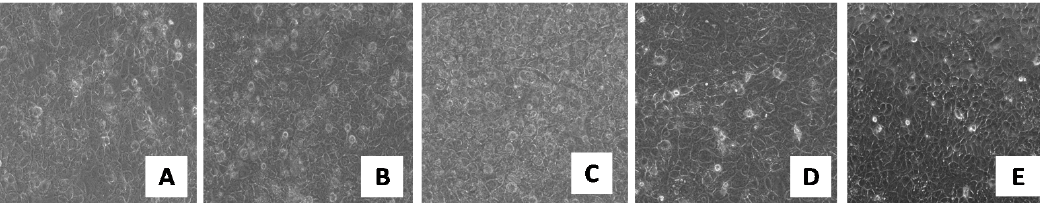
Figure 8. Keratinocytes visualized under a phase-contrast inverted light microscope (magnification 40×) after being treated with the following samples: ( A ) LVM; ( B ) CP3LVM; ( C ) H4LVM; ( D ) CT4LVM; ( E ) Control.